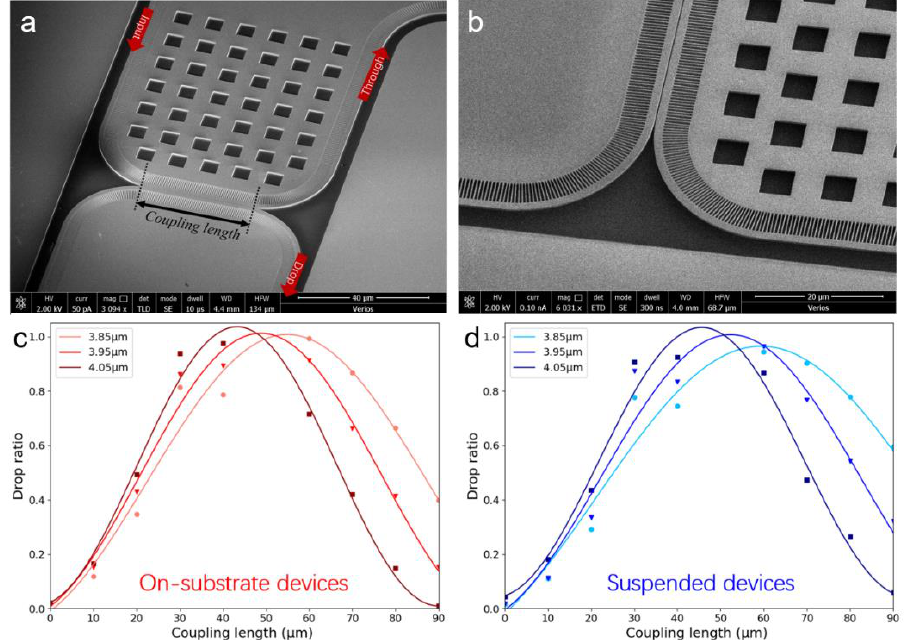
Figure 6. ( a ) SEM photo of an on-substrate waveguide coupler. ( b ) SEM photo of a suspended waveguide coupler. ( c ) Measured drop ratio of the on-substrate devices. ( d ) Measured drop ratio of the suspended devices.